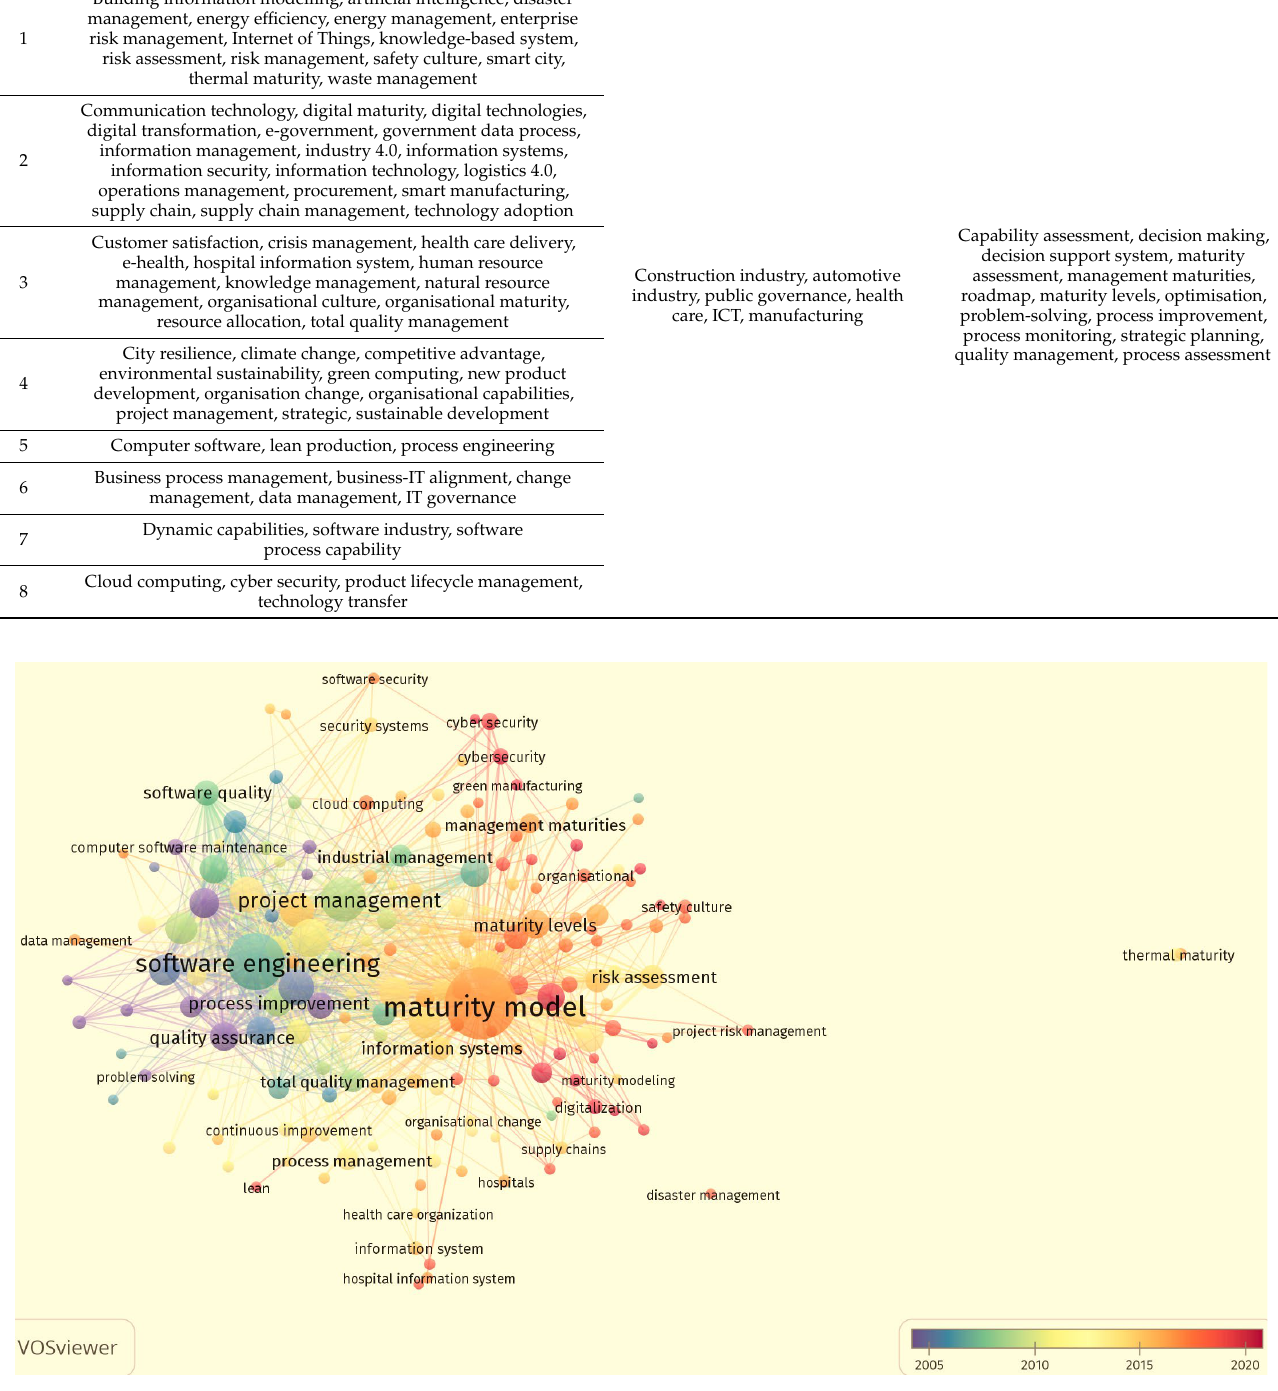
Figure 2. Overlay visualisation based on year .